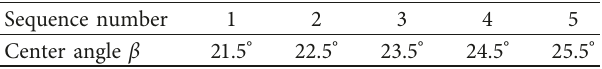
Table 3: Hose joint with different center angles.